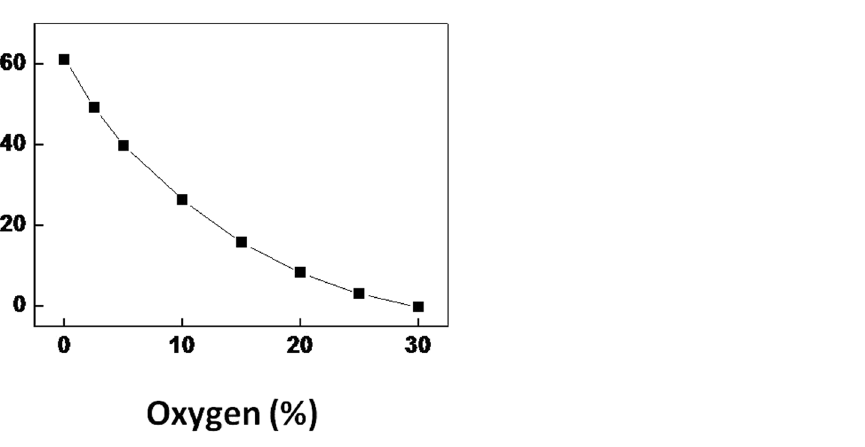
Figure 4. The difference between the observed N d (chlorophyll-specific rate of acetylene reduction) and the values in the range 0–30% O 2 , calculated from the linear extrapolation of the linear function of N d in the range 30–90% O 2 . The deviation from the linear relationship is largest at 0% O 2 , gradually decreasing to zero at 30% O 2 . The observed curve represents the variable gas flux into the